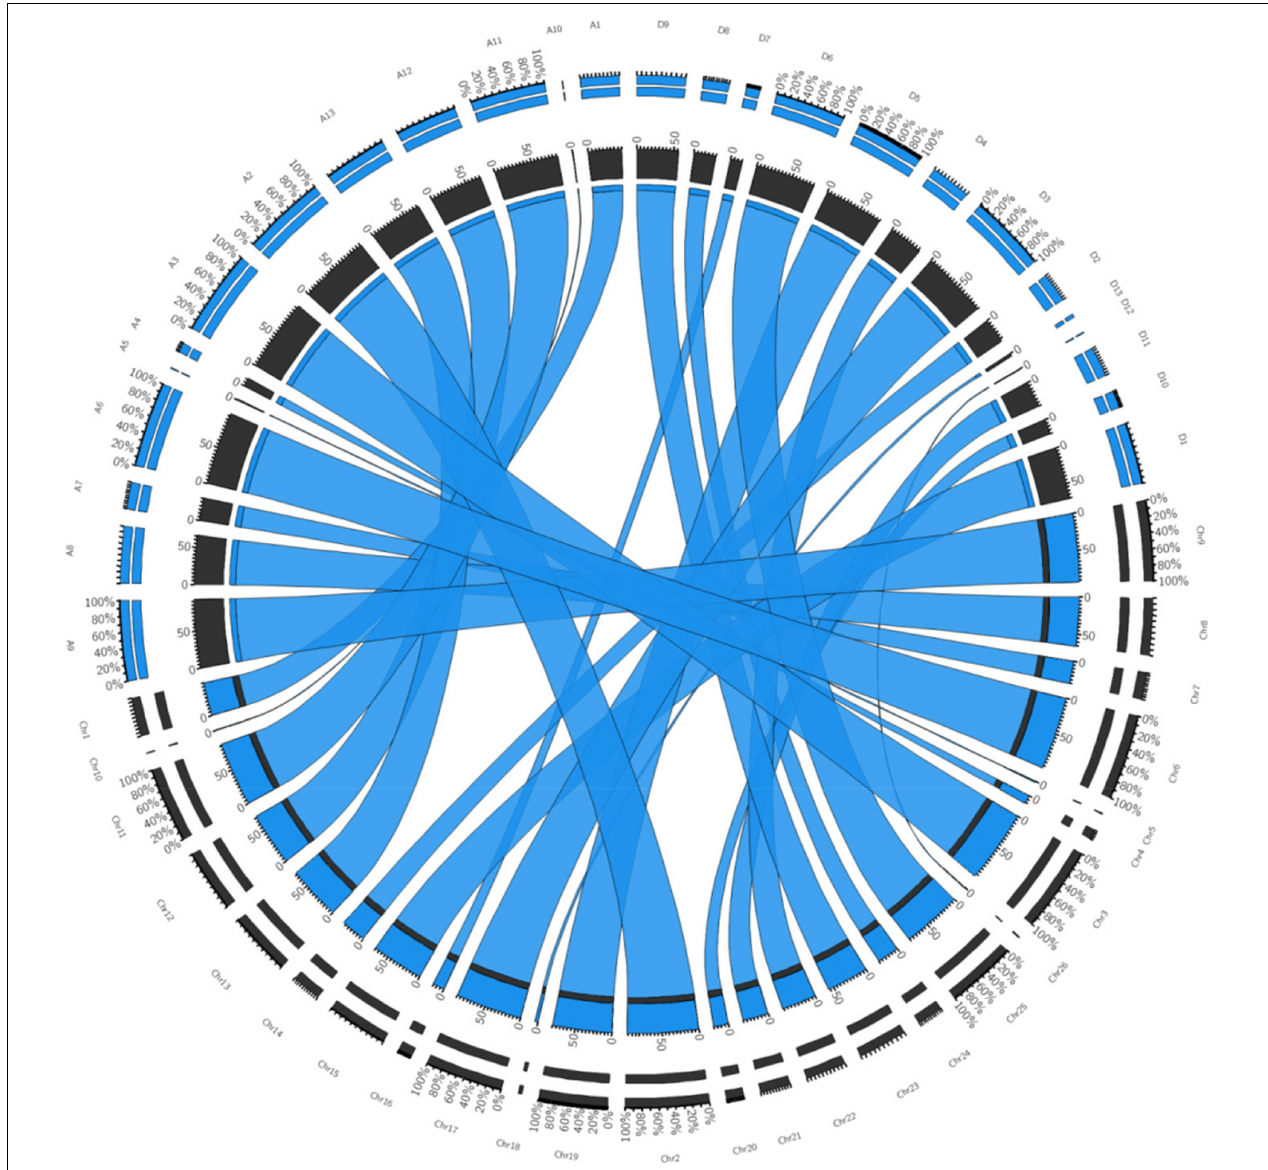
FIGURE 2 | Collinearity of the TM-1 sequence based physical map (https://www.cottongen.org/analysis/251) corresponding to SNP-based genetic map constructed in this study. Chr1–Chr26 (represented in black color segment) are chromosome number of intraspecific map developed in this study. A01–A13 and D01–D13 (represented in blue color segment) are physical map of TM-1 taken from the CottonGen public database. Inner black (genetic map of present study) and blue segment (physical map of TM-1 from CottonGen) represents the total percentage of similarity, blue color ribbon represents co-linearity among homologous chromosomes, outer double segment represents the relative percentage contribution of chromosomes being